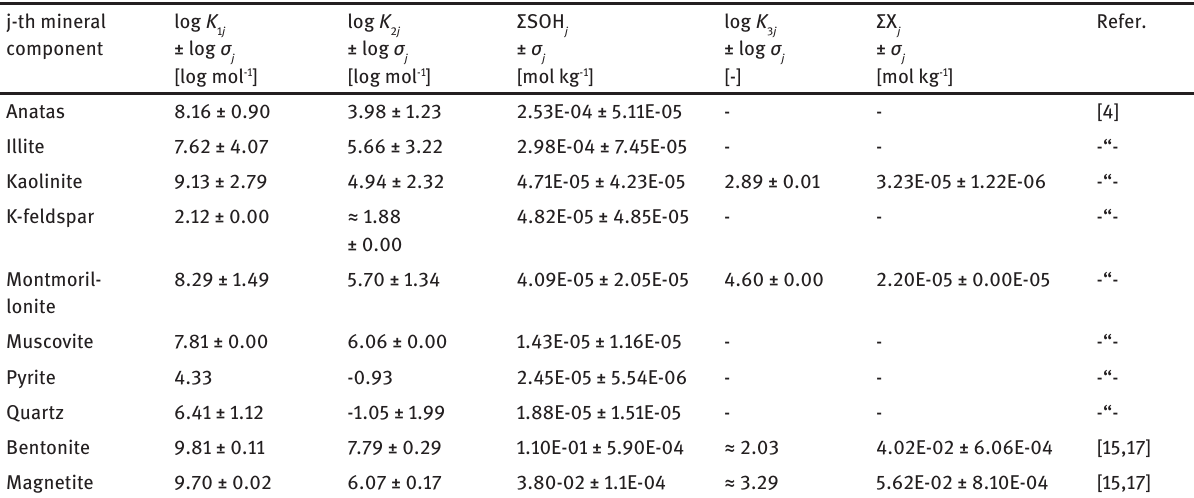
Table 2: Parameters of surface sites of selected components (average values ± standard uncertainties) (the values of equilibrium constants were extrapolated to I = 0 by means of Davies equation) (there are input data for CA-approach code in this table).